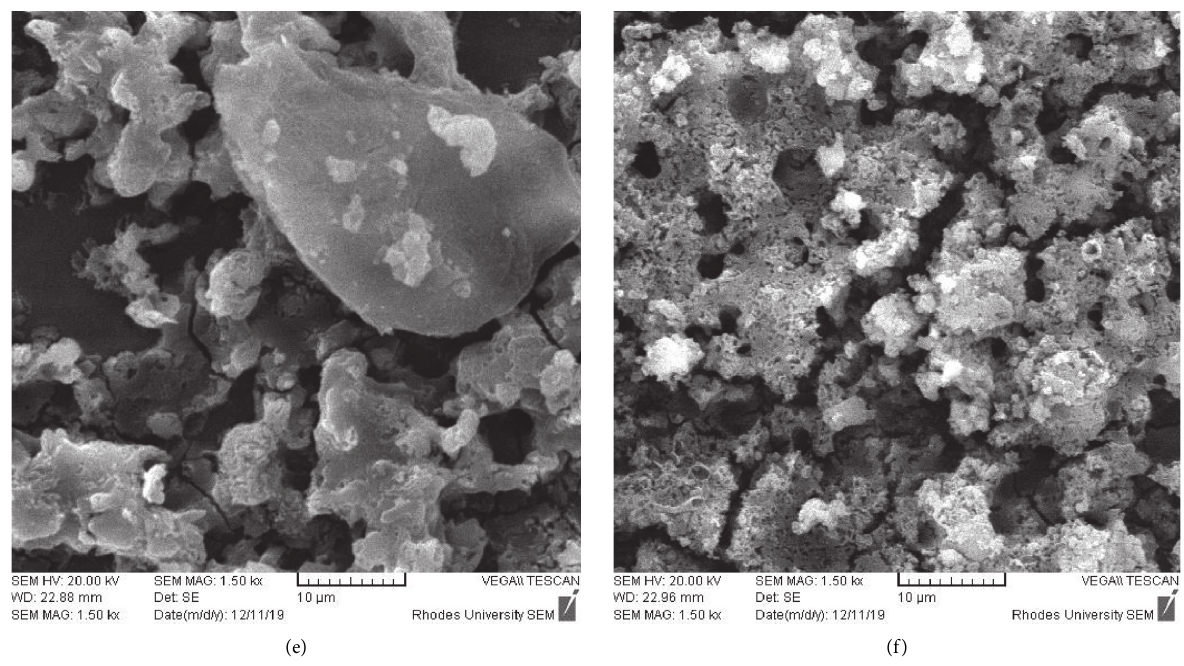
Figure 4: SEM of aluminium alone before (a) and after (b) corrosion. Electrodeposited- 2 before (c) and after (d) immersion in HCl and electrodeposited- 1 before (e) and after (f) immersion in HCl. Table 3: XRD absolute and relative intensity